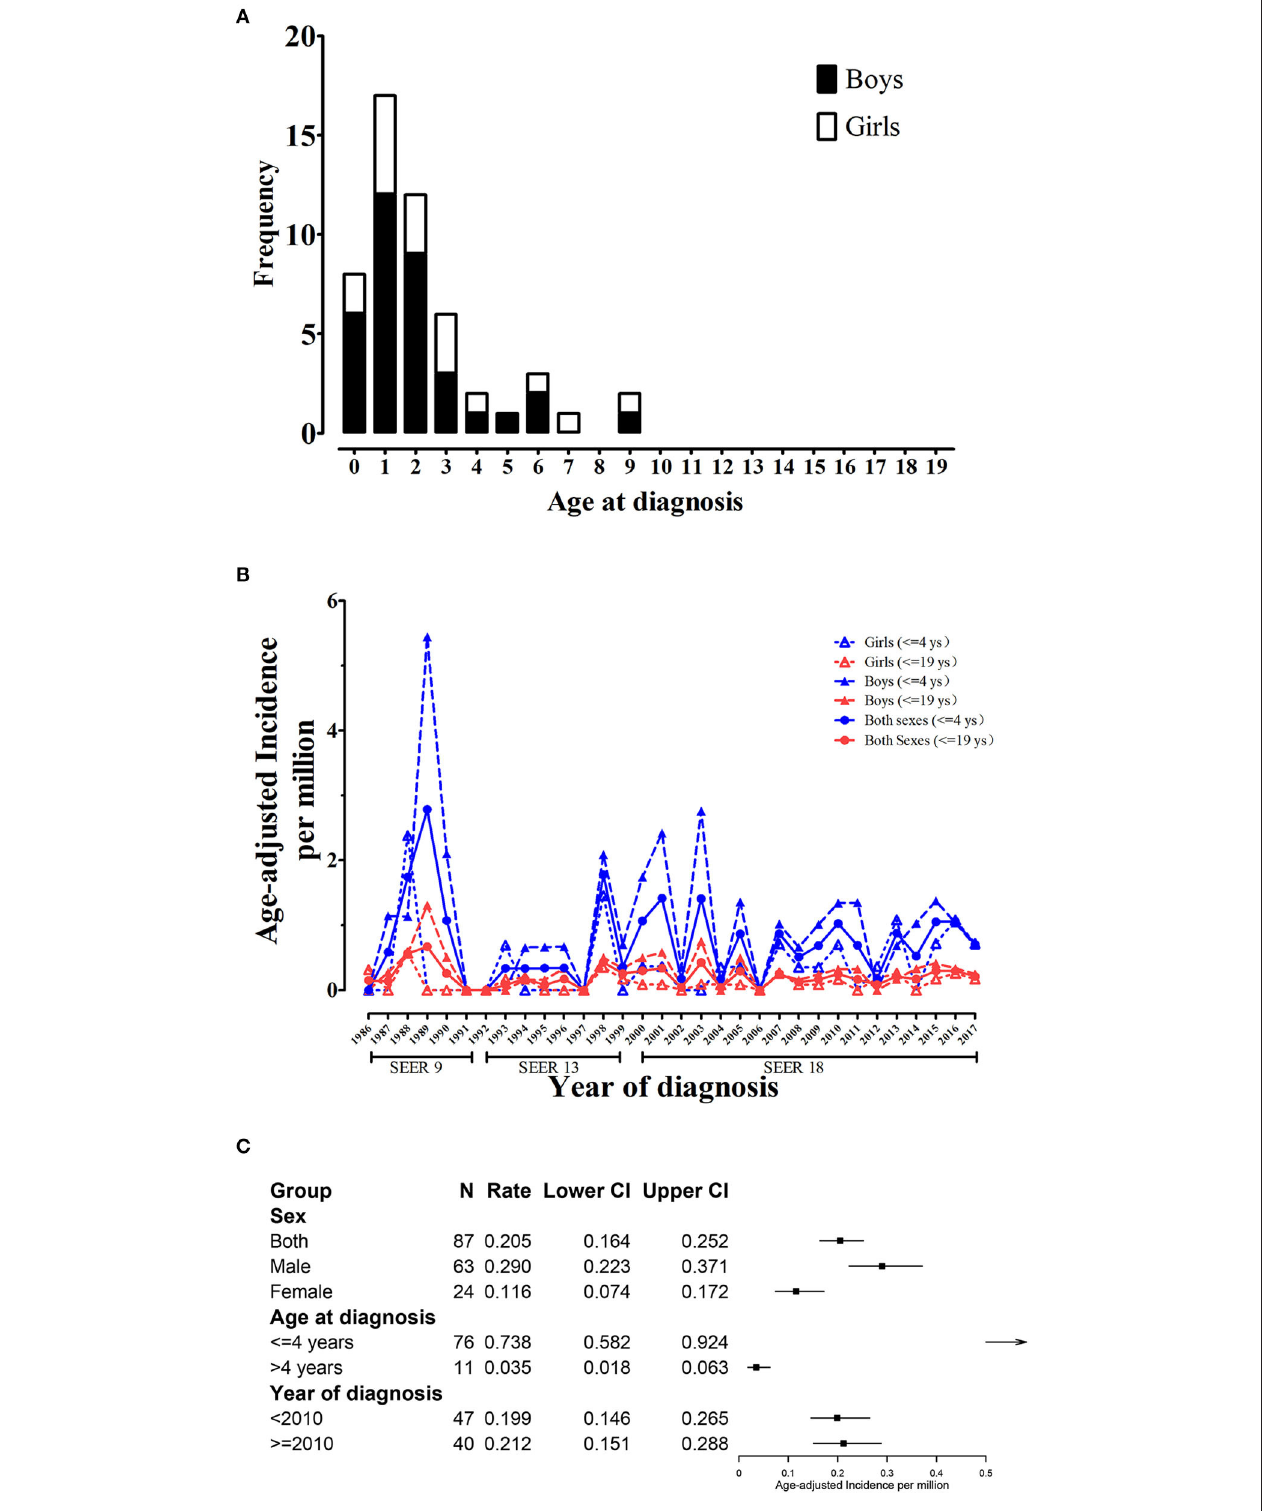
FIGURE 1 | Age and sex-specific incidence trend of childhood CCSK (0–19 years). (A) Age and sex-specific number of childhood CCSK during 1986–2017; (B) Age and sex-specific trend plot of age-adjusted incidence of childhood CCSK during 1986–2017. (C) Group-specific age-adjusted incidence for CCSK. CCSK, clear cell sarcoma of